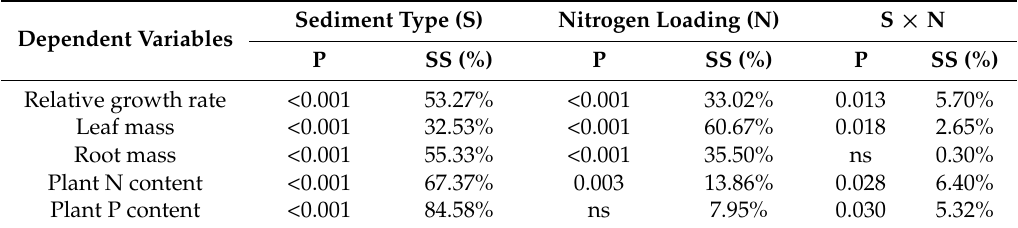
Table 2. Analysis of two-way ANOVA results for relative growth rate, leaf mass, root mass and plant nutrient contents of V. natans grown in two types of sediment and with two levels of external nitrogen loading at the end of